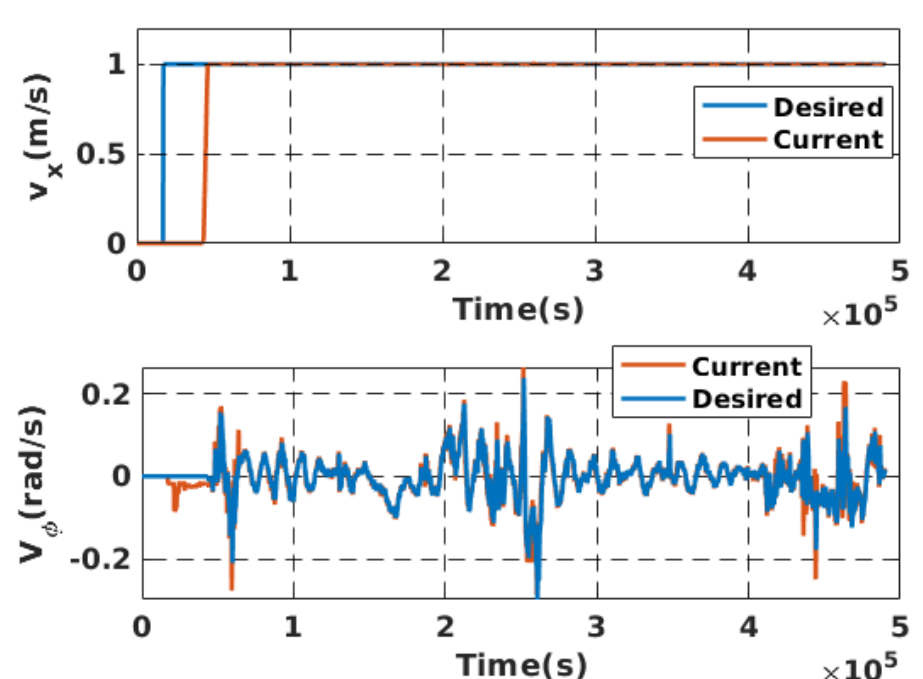
Figure 15. ( Top ): The commanded forward velocity. ( Bottom ): The commanded heading rate of